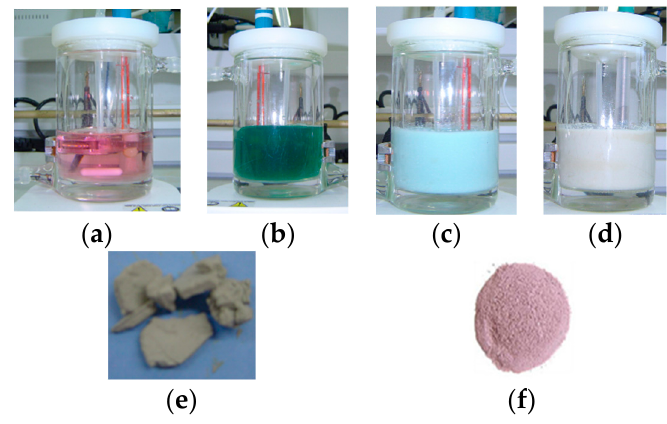
Figure 1. ( a ) Impregnation solution of Co(H 2 O) 62+ , ( b ) after base addition and pH = 8.5, ( c ) after the addition of TiO 2 , ( d ) after deposition for 5 days, ( e ) image of equilibrium deposition filtration method (EDF) catalyst after filtration, and ( f ) image of dry impregnation (DI) catalyst after impregnation.